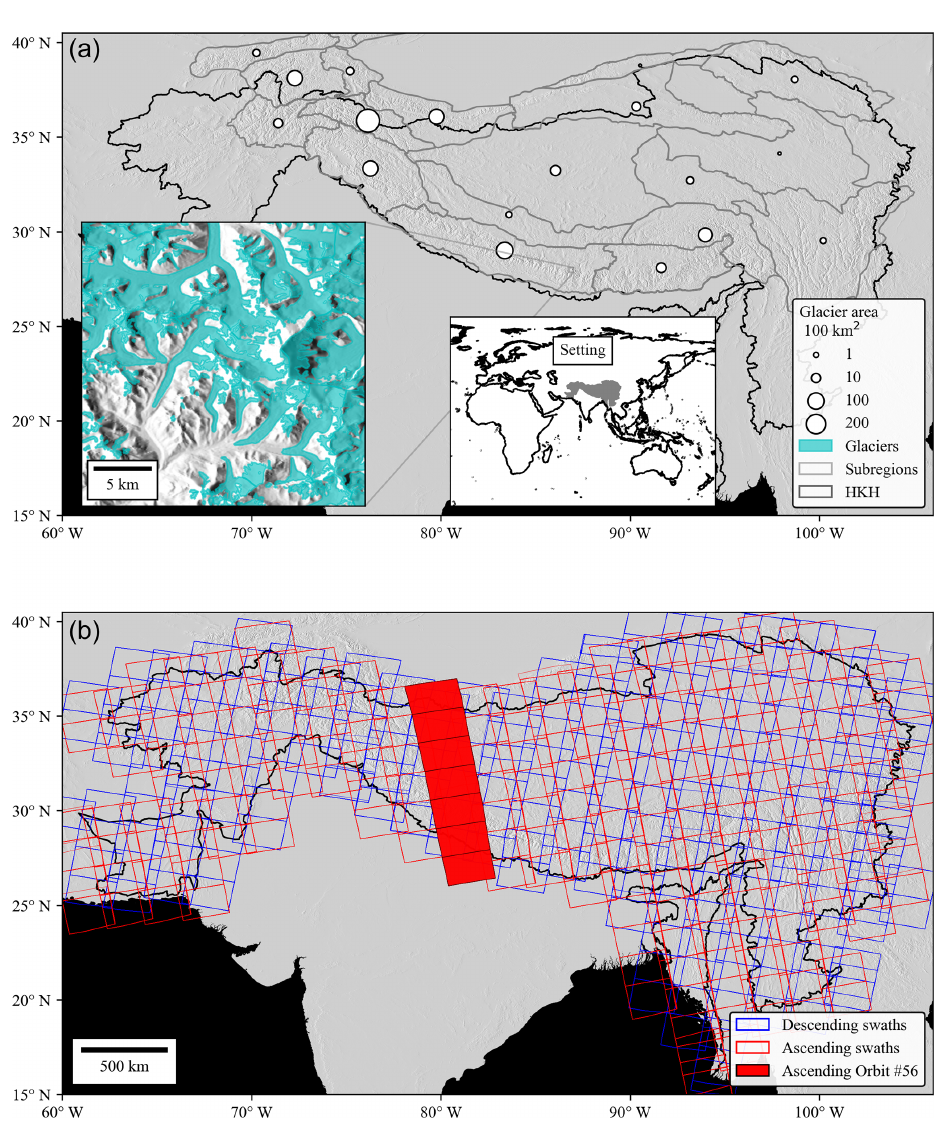
Figure 1. (a) Hindu Kush Himalaya (HKH) region and 2018 GAMDAM glacierized areas summed across glacio-climate sub-regions from Shean et al. (2020). An inset map highlights the spatial fidelity of GAMDAM outlines in the top panel. GGI and HKH data overlay a 30m Shuttle Radar Topography Mission (SRTM) digital elevation model (DEM) hillshade (Farr, 2007). (b) Sentinel-1 ascending- (red) and descending-swath (blue) footprints acquired across the study region. Ascending-orbit cycle number 56 is highlighted in red to illustrate the SAR image processing approach for time series analysis across distinct orbit